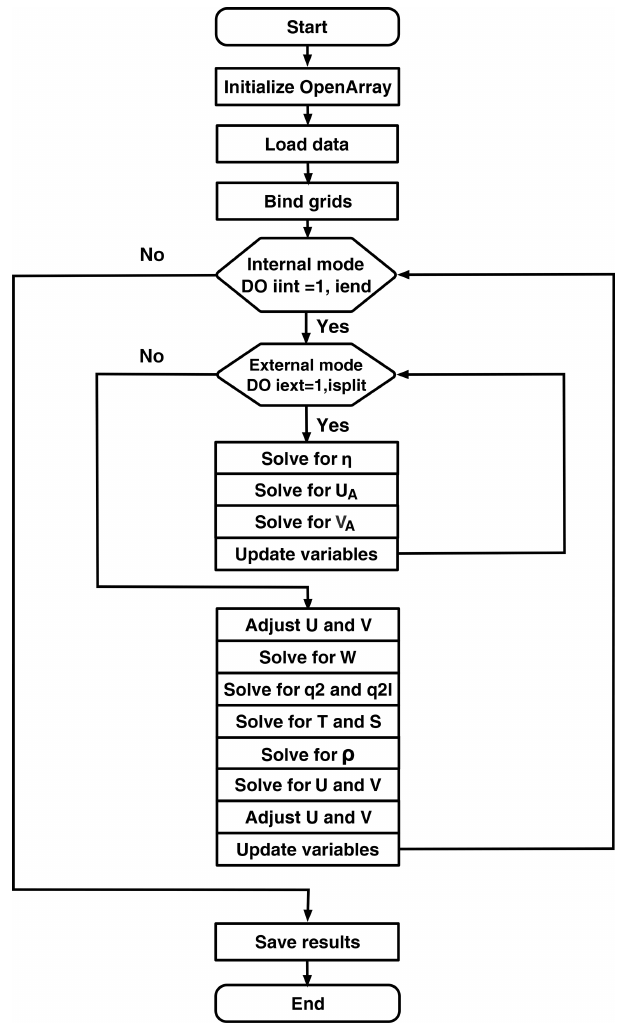
Figure 10. Flow diagram of GOMO.